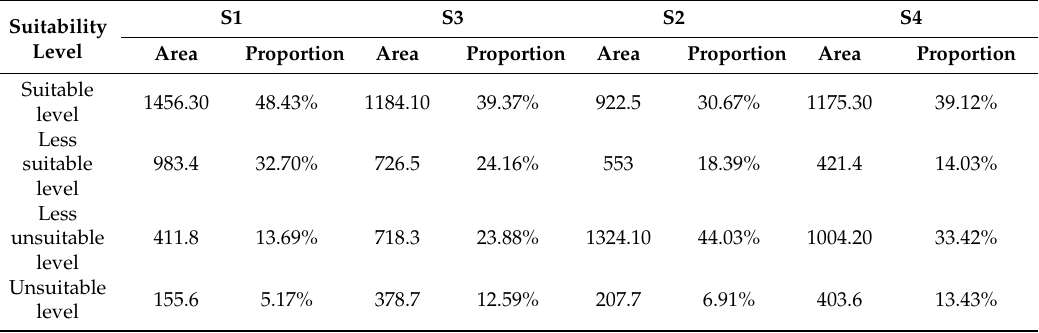
Table 3. Area (km 2 ) of habitat suitability levels and the proportion of each level to the total area of Poyang Lake at each of the four scenarios. S1: Wet year, no hydraulic project; S2: Dry year, no hydraulic project; S3: Wet year, hydraulic project present / operating; S4: Dry year, hydraulic project present /